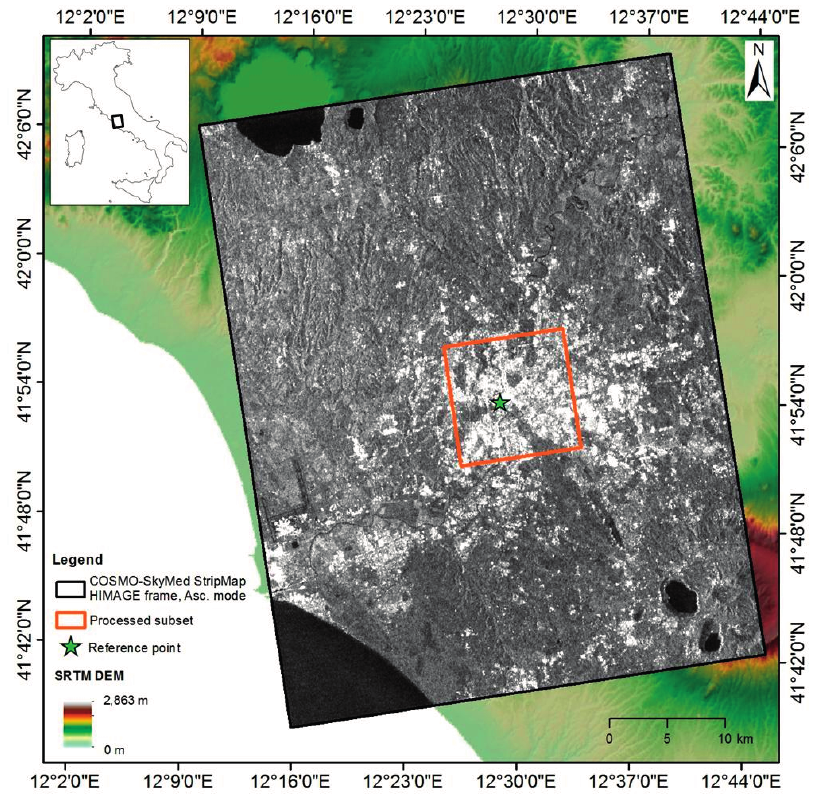
Figure 1. COSMO-SkyMed StripMap HIMAGE SAR image frame acquired along ascending orbits over the city of Rome, central Italy (© ASI (Agenzia Spaziale Italiana), all rights reserved), overlapped on SRTM DEM, with the identification of the processed subset and the location of the reference point used for the Stanford Method for Persistent Scatterers (StaMPS)